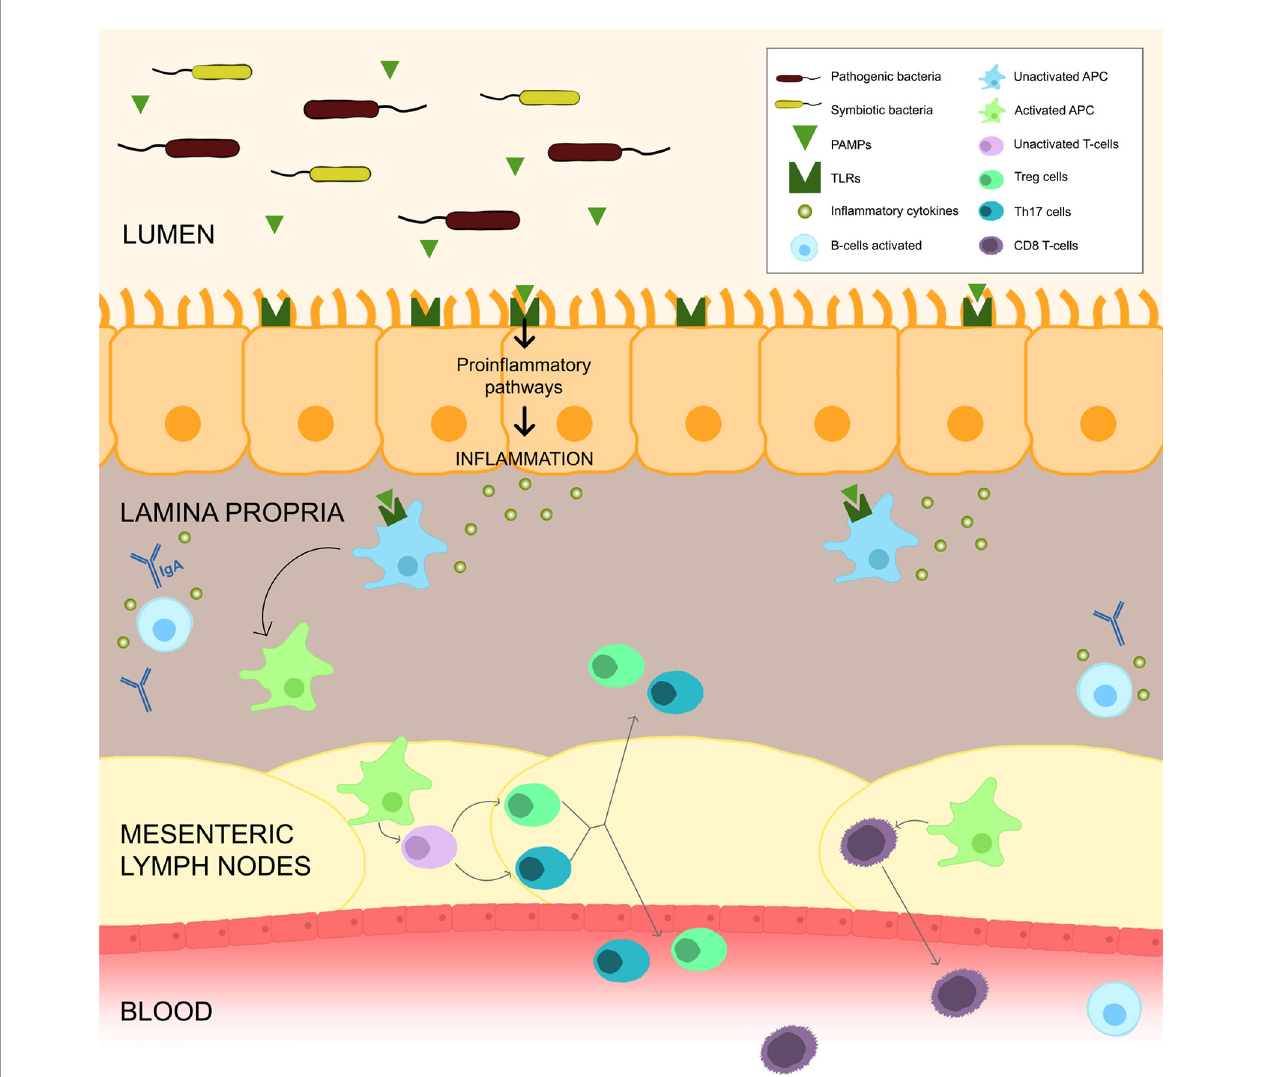
FIGURE 1 | Gut Microbiota and Immune System. Gut bacteria, through PAMPs, can upregulate the TLRs andactivate in fl ammatory pathways, which causes a release of cytokines leadingto an in fl ammation milieu.PAMPs can also activate APC which migrate to the mesenteric lymph nodes to stimulate T andB cells. Activation ofB cells to plasma cellsallows the release ofIgA into the lumen.APC activate CD4 T cells to differentiate into Tregs and Th17 cells, that can migrate back to the gut or enter systemic circulation and in fl uence immunity indifferent sites. APC may also stimulate CD8T cells into effectorcellsthat migrate from the gut to